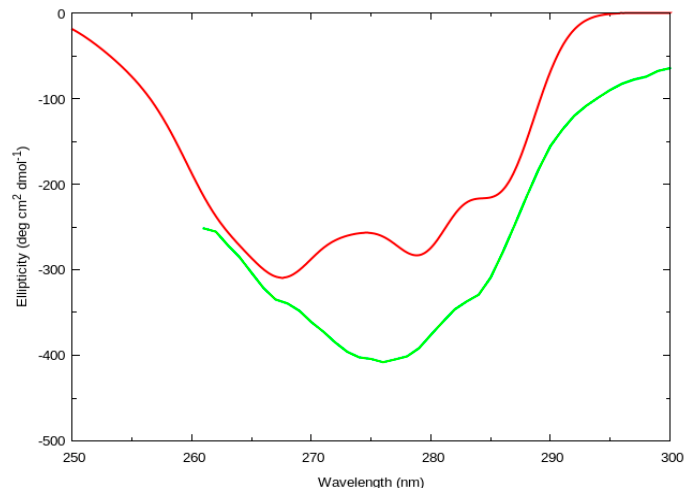
Figure 4. Computed (red line) and experimental (green line) [17] near-UV CD spectra for bovine pancreatic trypsin inhibitor (BPTI, PDB entry 1PIT). The computed spectrum is an average of rotational strength line spectra computed for 20 NMR models, using BB and VSC parameters for Tyr and Phe, and convoluted with a Gaussian of FWHM of 4.0 nm.